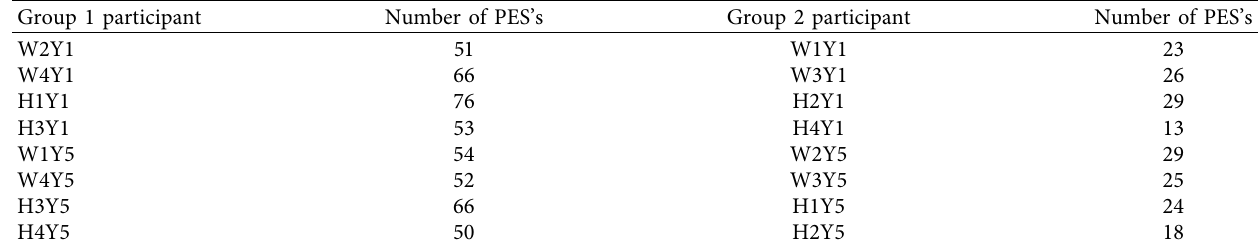
Table 2: Number of PES’s per participant.